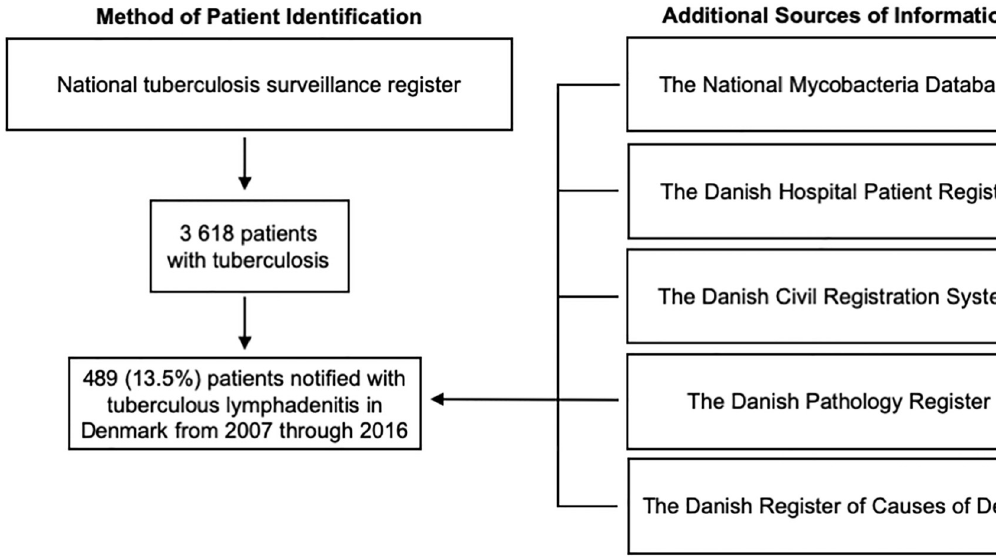
Fig 1. Danish registers used. Overview of the different nationwide registers used for patient identification and data extraction. All collected data relied on notification from the individual clinician(s) managing the patient.